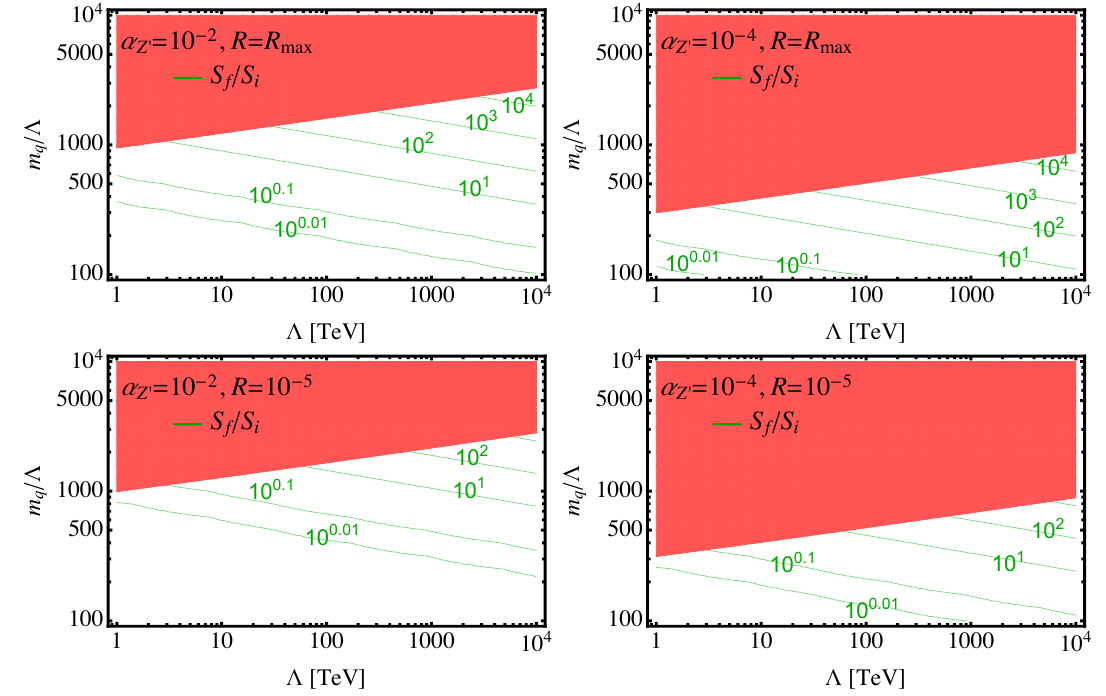
Figure 5 . Contours of the ratio of SM entropy after ( S f ) and before ( S i ) the glueball decay, for α Z 0 = 10 − 2 (left column), α Z 0 = 10 − 4 (right columns), R = R max (top row), and R = 10 − 5